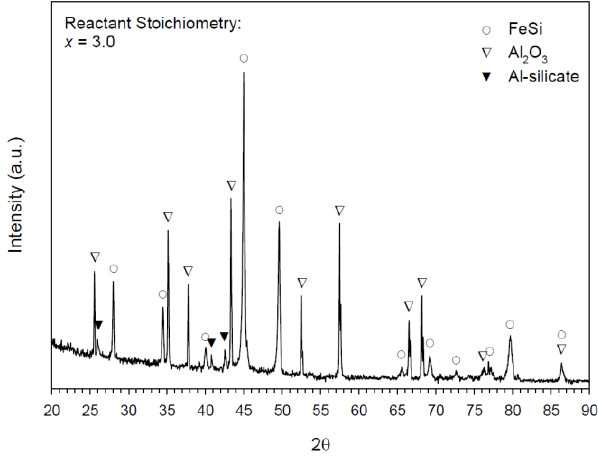
Figure 5. XRD patterns of Fe 3 Si/FeSi-Al 2 O 3 composites synthesized from Reaction (1) with ( a ) x = 1.5 and ( b ) x = 2.0.